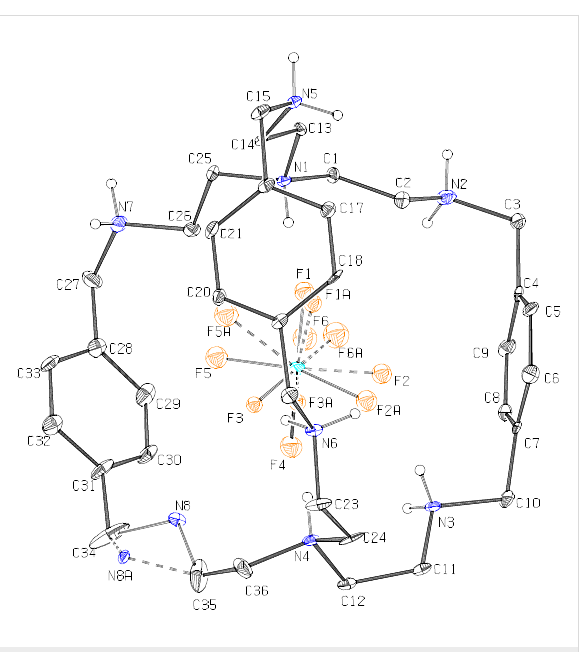
Figure 7: ORTEP diagram depicting the octaprotonated [H 8 L 1 ] 8+ moiety with the encapsulated disordered HSiF 6− monoanion with atom numbering scheme (25% probability factor for the thermal ellipsoids and only hydrogen atoms attached to the amino nitrogens are shown for